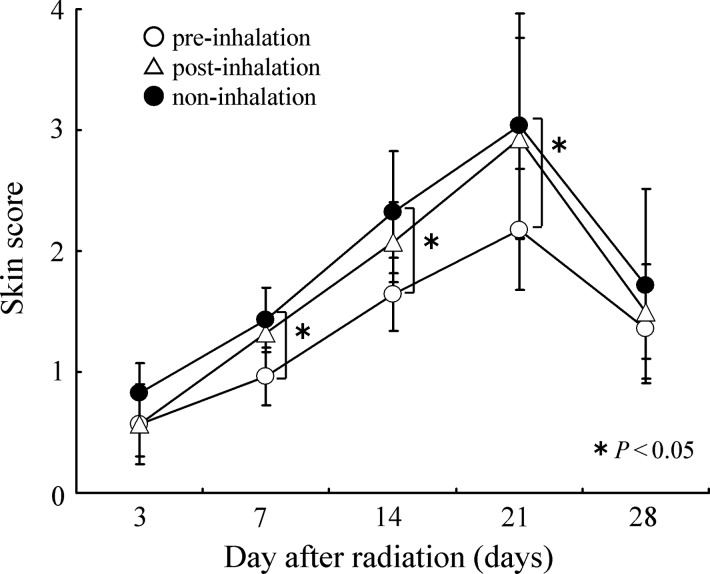
The chronological change in the skin score for acute dermatitis after 20-Gy irradiation. In each group (n = 14), scores peaked at 3 weeks and then tended to decrease. A significant radioprotection effect was observed in the pre-inhalation of HCG group compared with the post- and non-inhalation group on Days 7, 14 and 21.